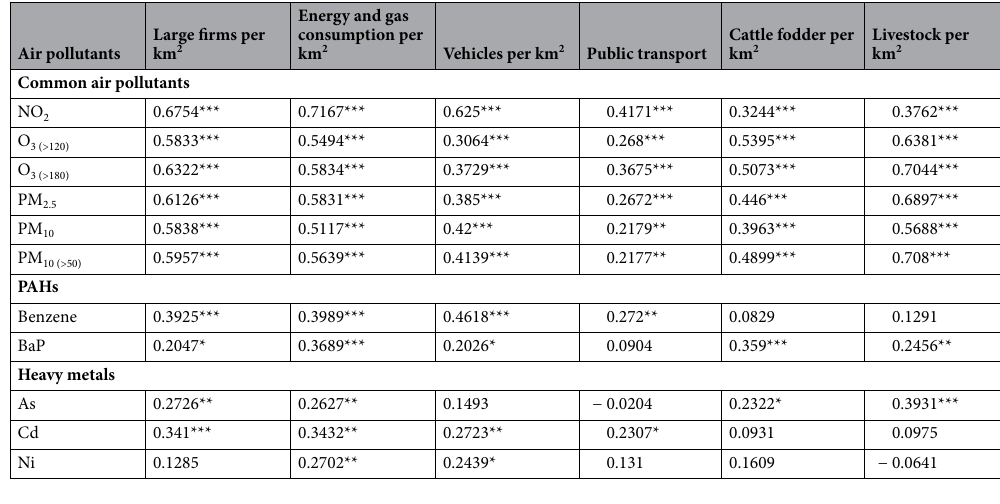
Table 1. Spearman’s rank correlation coefficients between nine air pollutants and six potential sources of environmental pollution. p-value < 0.01***; p-value < 0.05**; p-value <